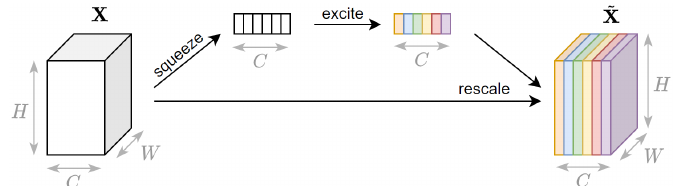
Figure A1. Overview of the Squeeze-and-Excitation block used in the OFCN encoder. The SE blocks are inserted after each ReLU activation.